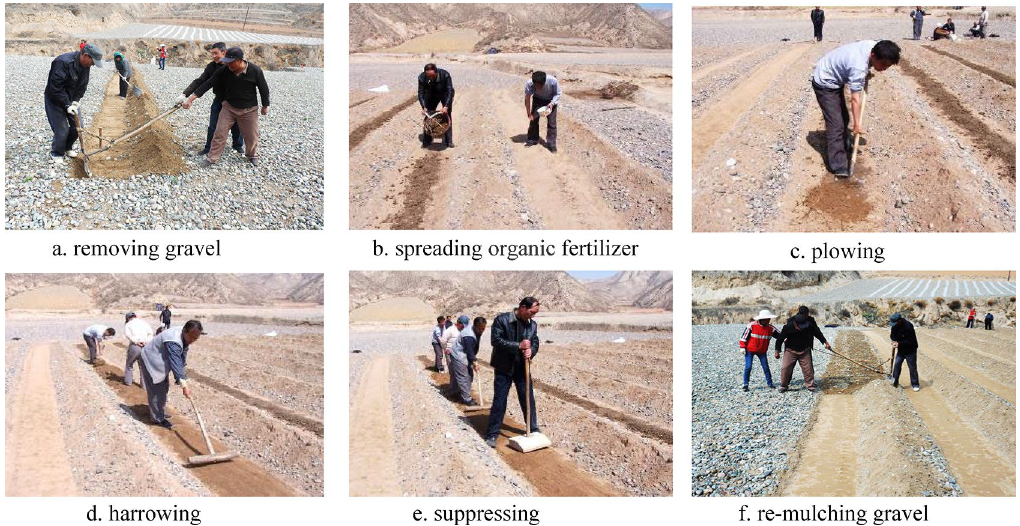
Figure 1. Application process of farm manure in a gravel-mulched field. Note : There were not any authors of the manuscript in this figure. All the people involved are farmers temporarily employed in the field experiment, and the written informed consent was obtained from these farmers for